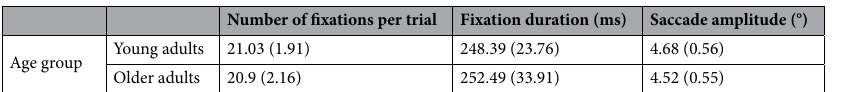
Table 1. Mean (and standard deviation) general scanning behaviour per participant for young and older